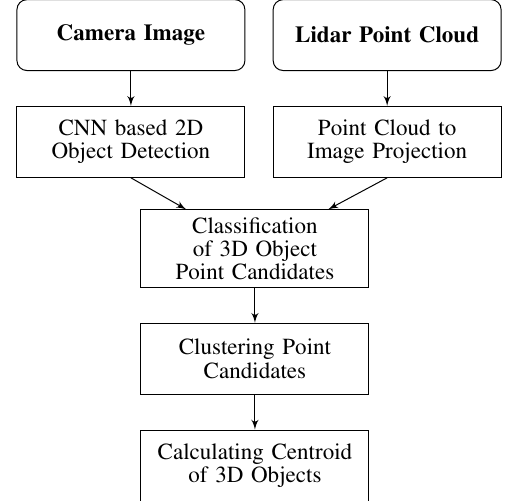
Figure 1. Flowchart showing the processing chain of the proposed